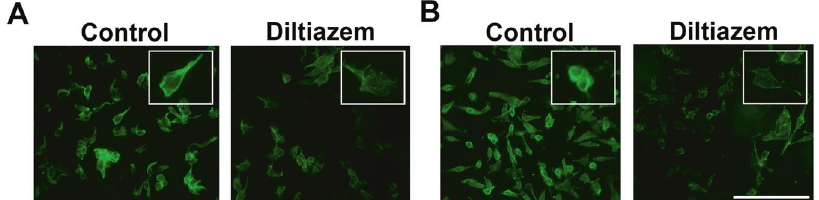
Fig. 3 Diltiazem attenuates F-actin disassembly and reorganization in breast cancer cell lines. After treating with 50 μ M diltiazem for 24 h, F-actin dynamics was revealed by FITC-phalloidin staining. Note that F-actin disassembling was attenuated by diltiazem on both 4T1 ( A ) and MDA-MB-231 cells ( B ) in representative images. Scale bar, 100 μ m.